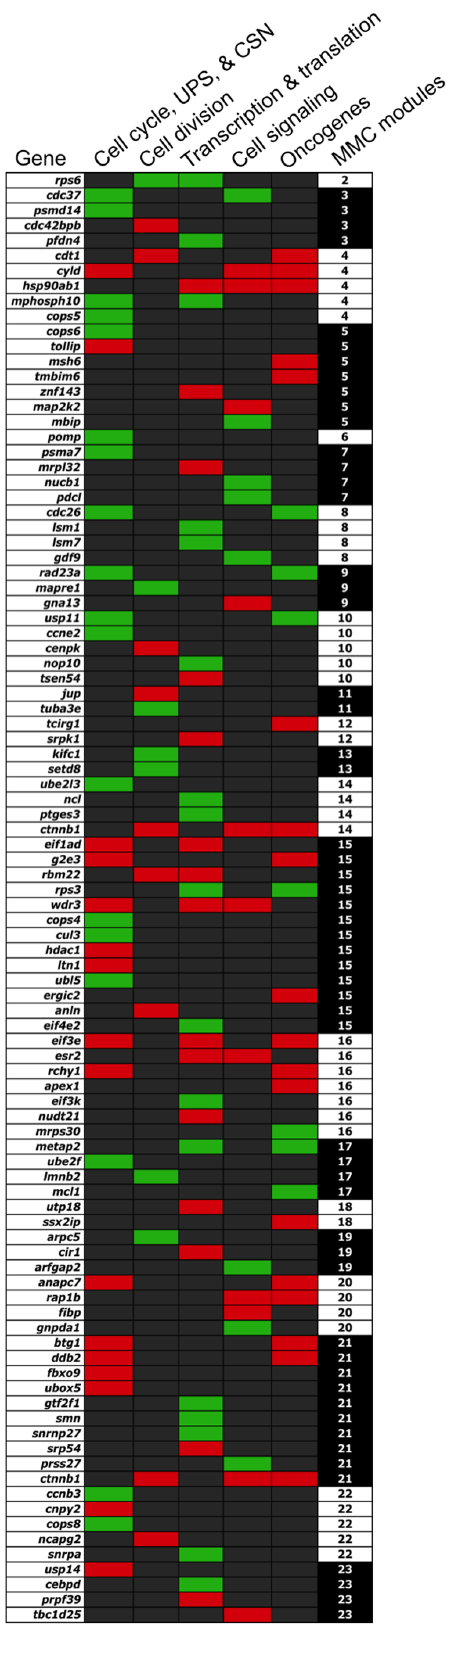
Figure 4. Matrix of a subset of genes that co-vary in expression and share GO classes or functional pathways. Presence of a red or green box indicates assignment of a gene to a functional category and up- or down-regulation, respectively, in fish spawning poor quality eggs (see also Table S2 ). MMC module indicates gene assignment to networks depicted in Fig.